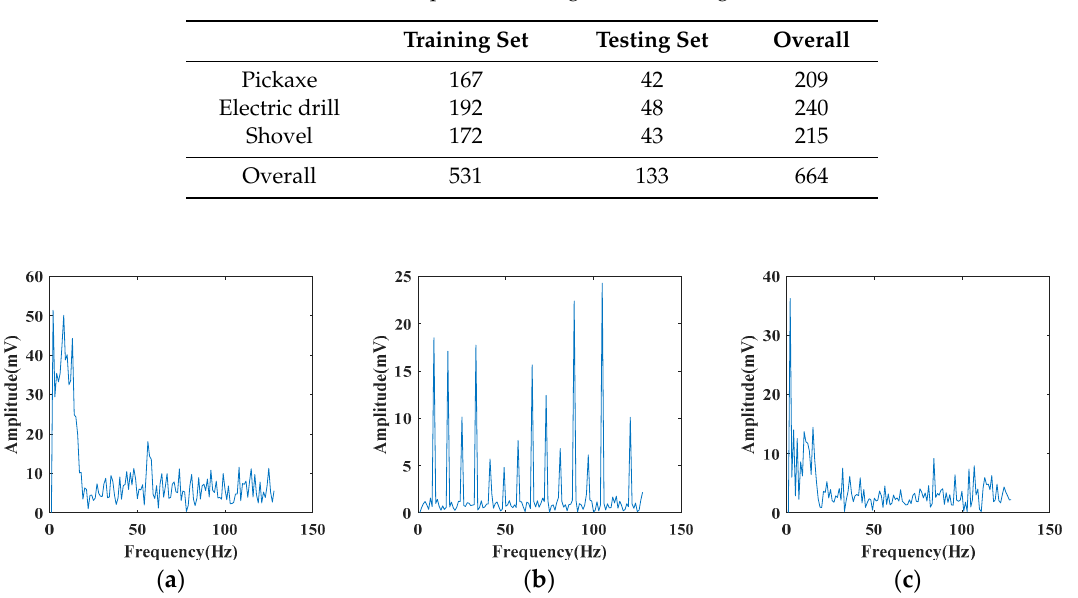
Figure 6. Fiber vibration signals in time domain: ( a ) pickaxe; ( b ) electric drill; ( c ) shovel. Figure 7. Fiber vibration signals in frequency domain: ( a ) pickaxe; ( b ) electric drill; ( c ) shovel. Table 1. Samples of training set and testing set